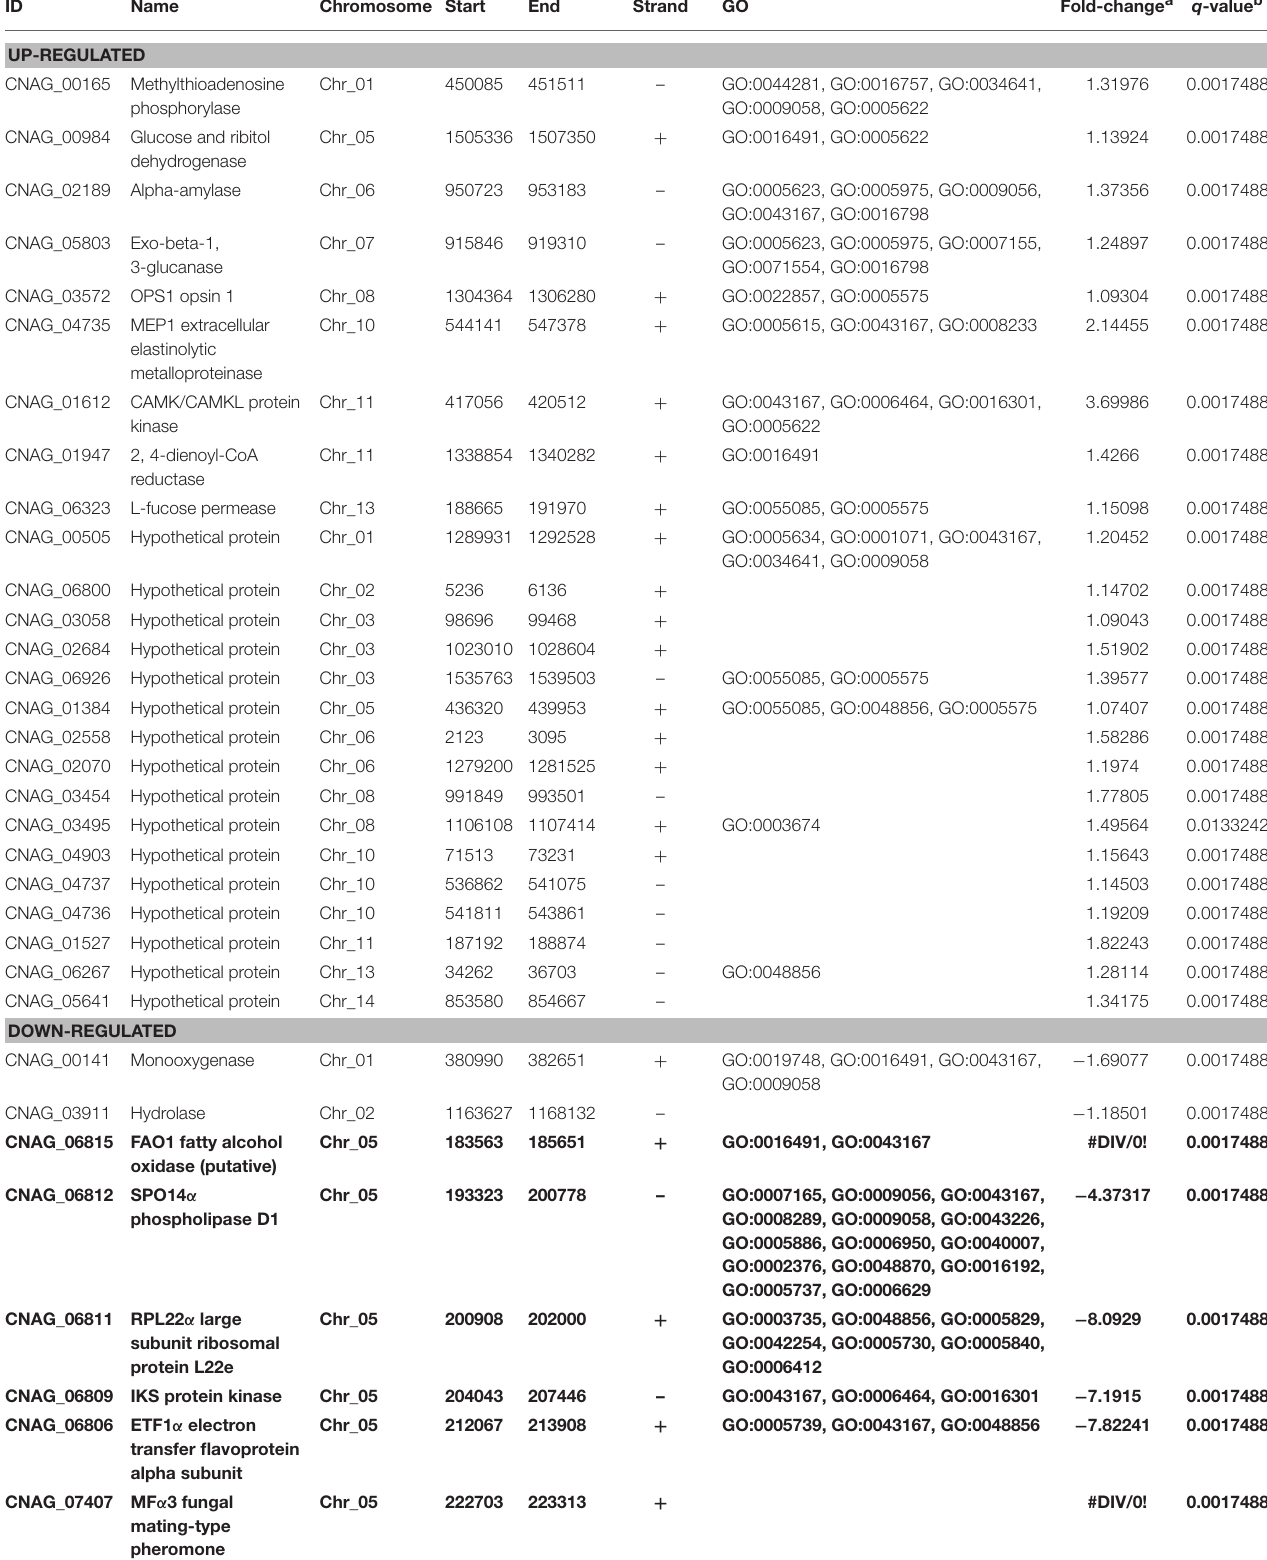
TABLE 1 | Differential # transcripts in the rcv1 1 mutant after 4h in CIM at 37 ◦ C, relative to